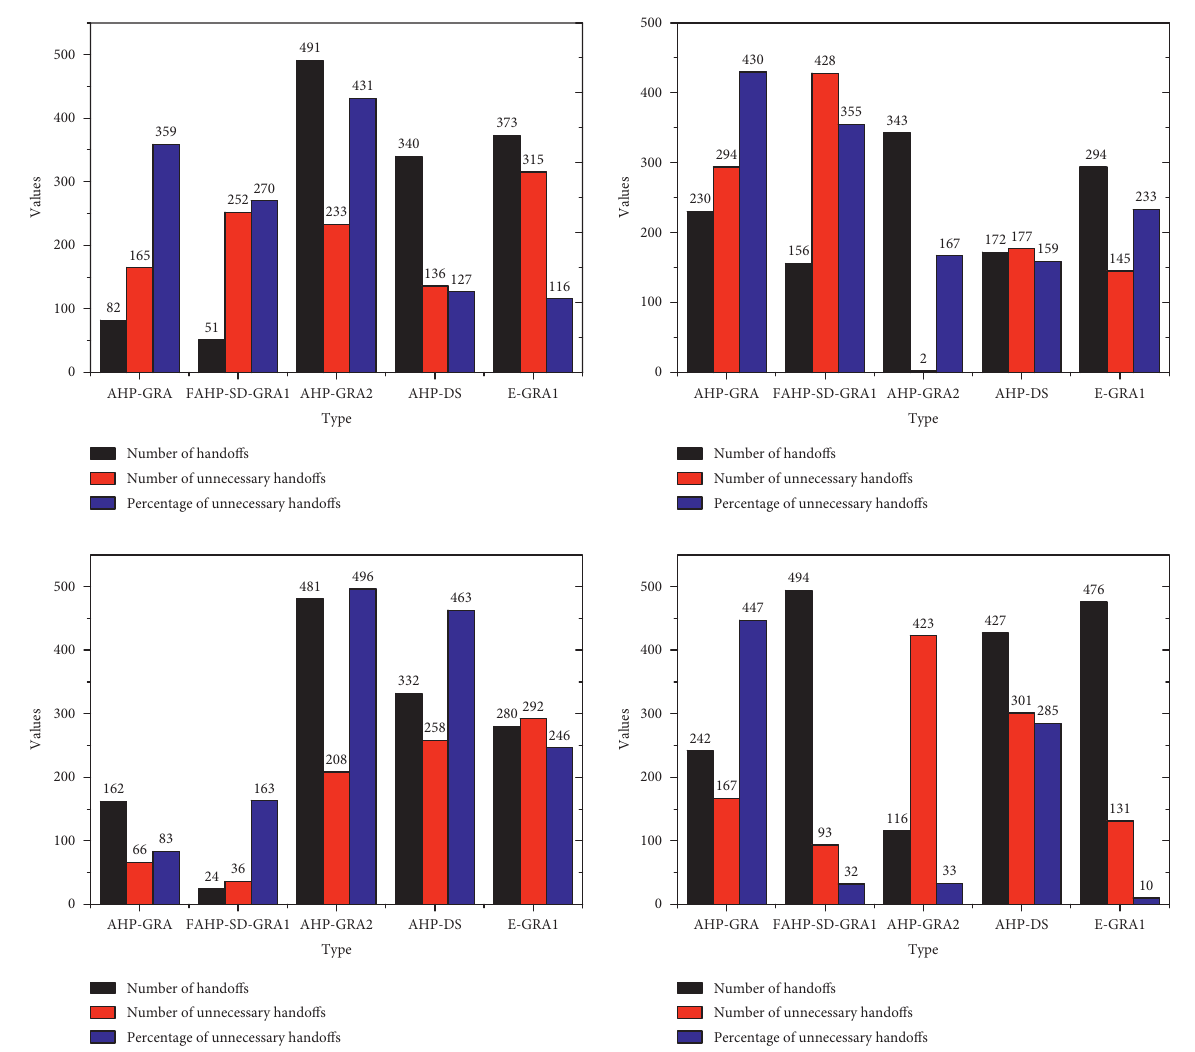
Figure 5: Number of unnecessary vertical switches assuming all algorithms use the same difference threshold.